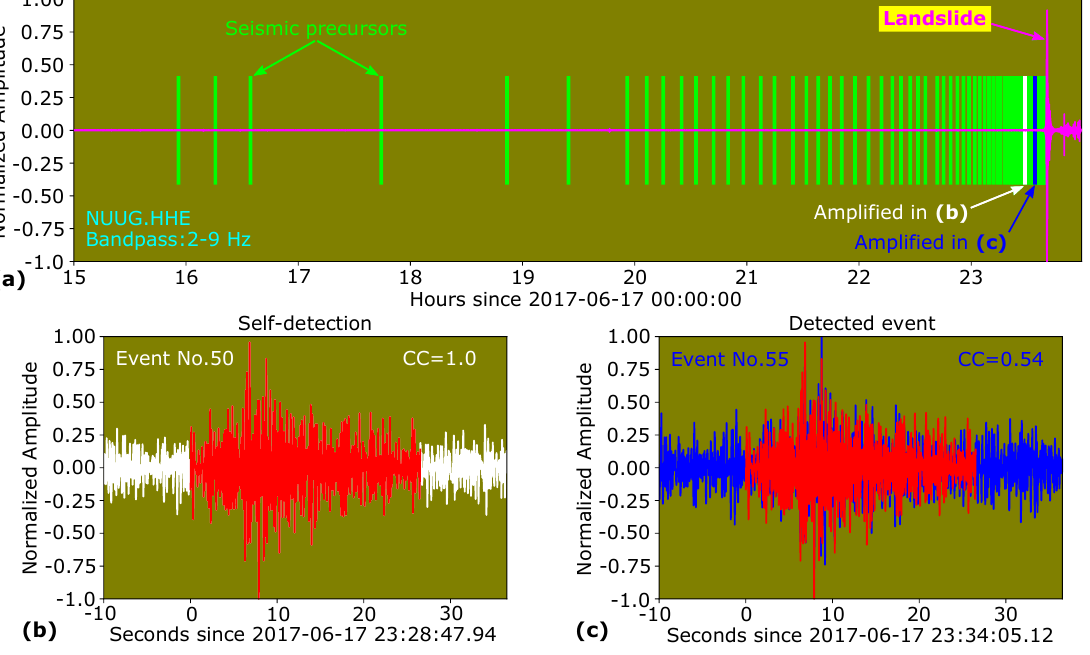
Figure 2. Seismic waveform. ( a ) East component (fuchsia line) of station NUUG. The waveform is normalized and band-pass filtered between 2 and 9 Hz [9]. Colored (lime, white, and blue) vertical bars denote the seismic precursors. ( b ) Self-detection (event No. 50). ( c ) An example of detected event (No. 55). For both ( b , c ), the template waveform (event No. 50, red line) is superposed at the location of the best match according to the MFMC method.